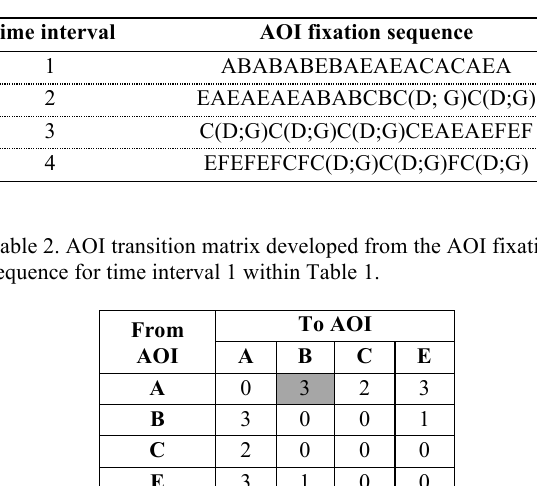
Table 1. Samples AOI fixation sequences having overlaps